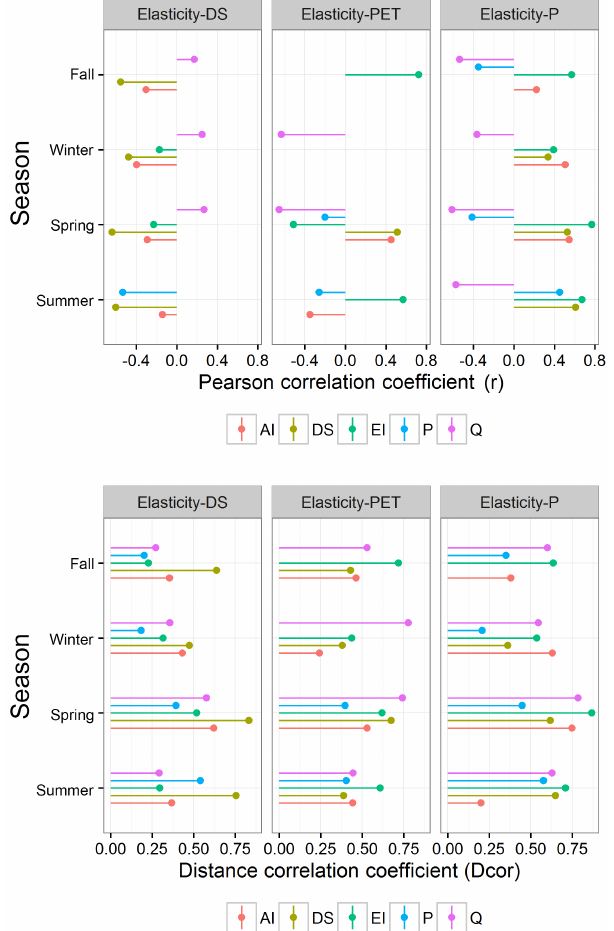
Figure 10. The linear and nonlinear association strengths as deter- mined by Pearson and distance correlation coefficients. (Note: in the figure, we have sorted the strength of association separately for each season and the hydroclimatic variables are represented by dif- ferent colors and only statistically significant ( p <0.05) correlation strengths are shown